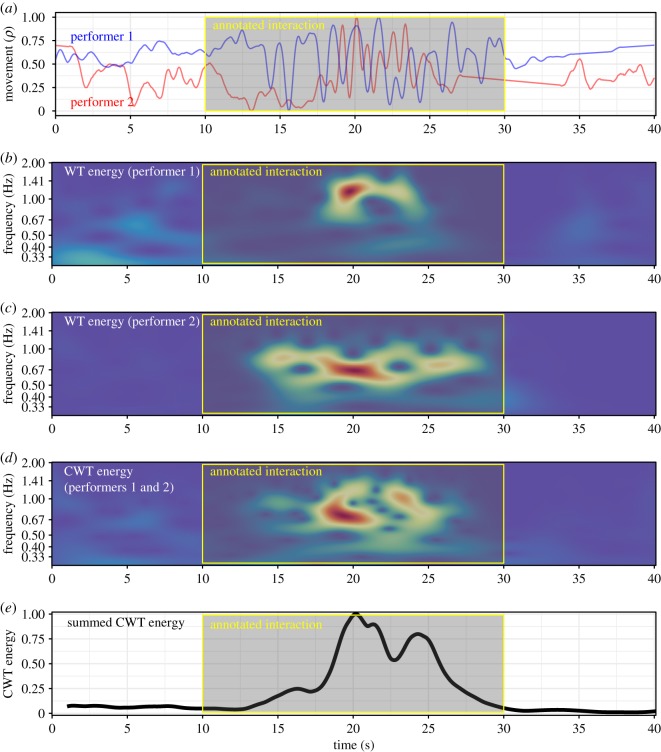
CWT example from the data (non-pulsed, ID Free_VP0506_08 at the dataset, extract from 50 to 90 s). Panel (a) shows the combined movement of each performer, panels (b) and (c) display the individual WT for each performer, panel (d) exhibits the CWT and panel (e) shows the energy of the CWT.